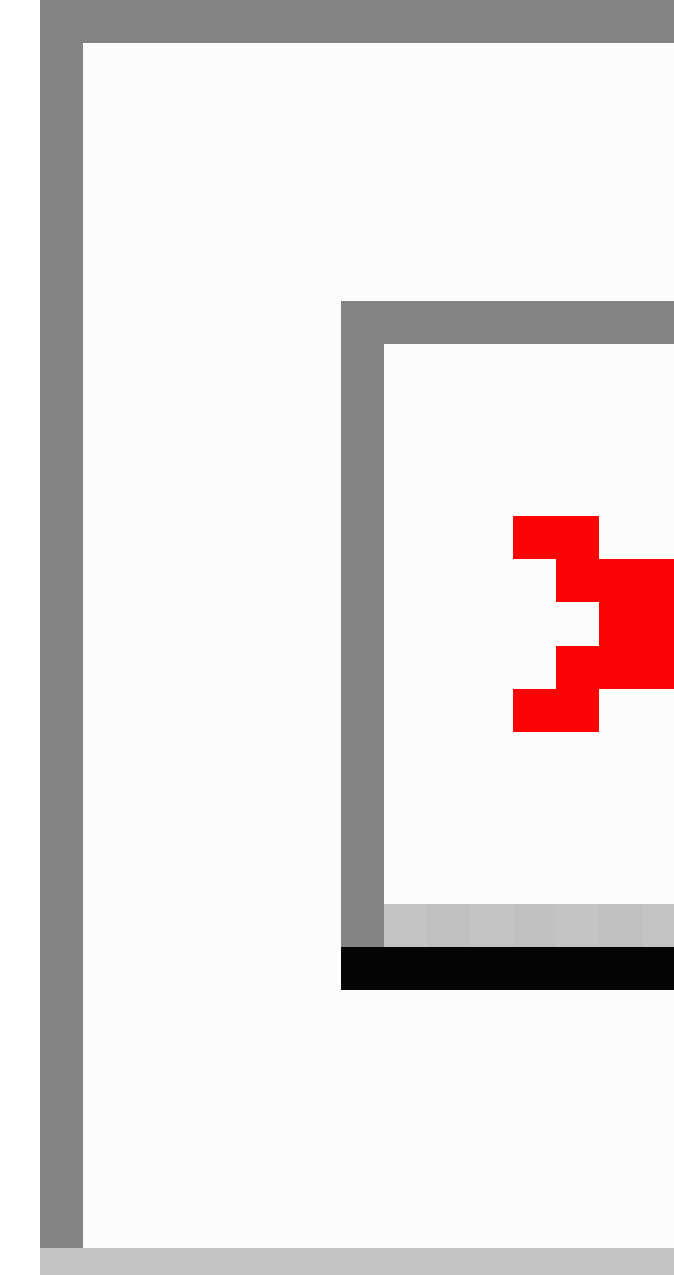
Figure 1. PRISMA flow diagram. RCT: randomized controlled